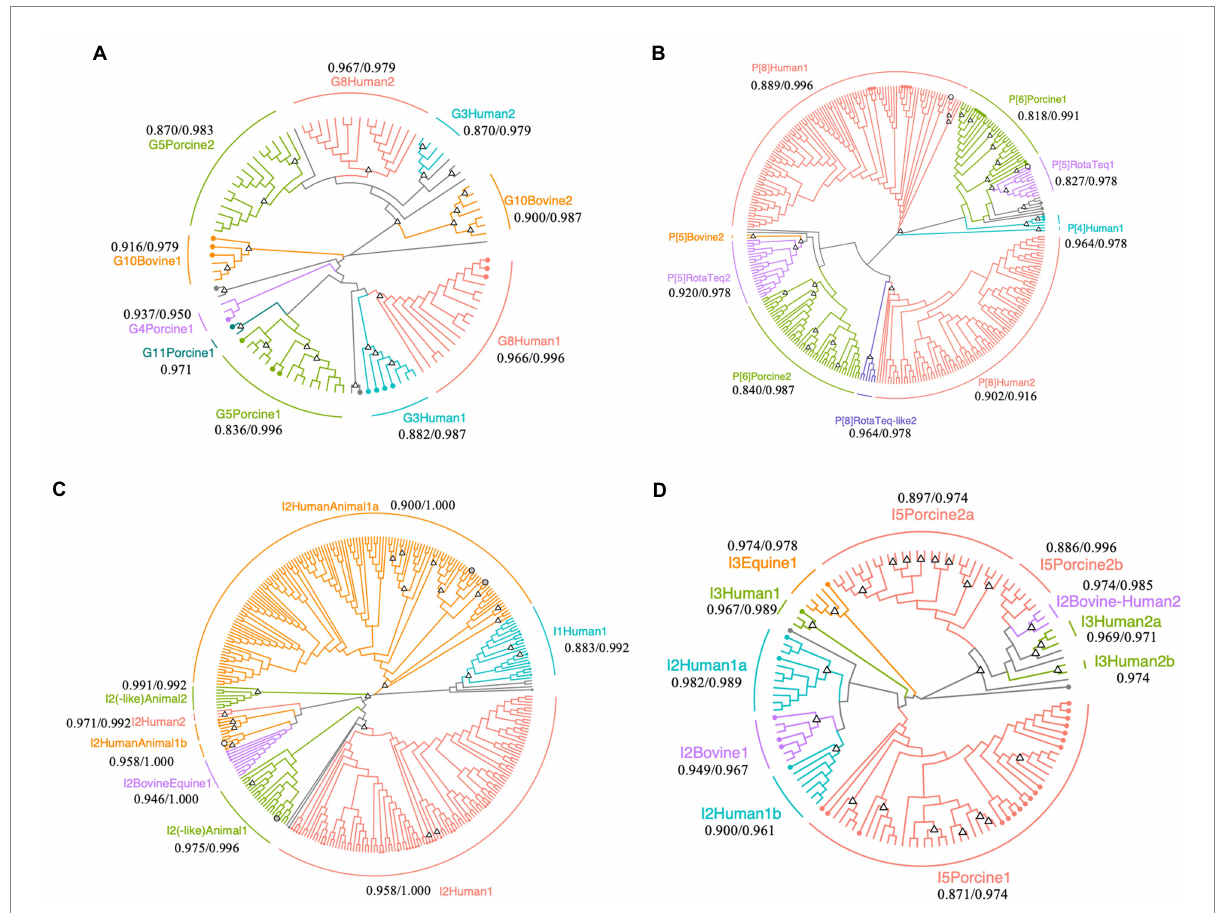
FIGURE 2 Phylogenetic trees of Rotavirus A strains detected in surface water samples collected at DWTP E. Trees were built for partial regions of the VP7 (A) , VP4 (B) , and VP6 genes (C,D) obtained using human and animal nested PCR assays with maximum likelihood and bootstrapped with 1,000 repetitions. The sequence lengths of VP7, VP4, and human and animal VP6 were 242, 230, 239, and 274 bp, respectively. Circles with branch colors represent reference sequences that are closely related to OTU sequences. White and gray circles represent reference sequences for RotaTeq ® and closely-related OTU sequences. The information of reference sequences is provided in Supplementary Table S3 in Supplementary material. Triangles at the nodes represent bootstrap rates of >0.8. The name of each sub-cluster consists of the genotype, followed by host or RotaTeq ® , 1 (cluster with reference sequences) or 2 (cluster with only OTU sequences), and a or b for more than two sub- clusters. The values represent the minimum/maximum sequence similarity within each sub-cluster.